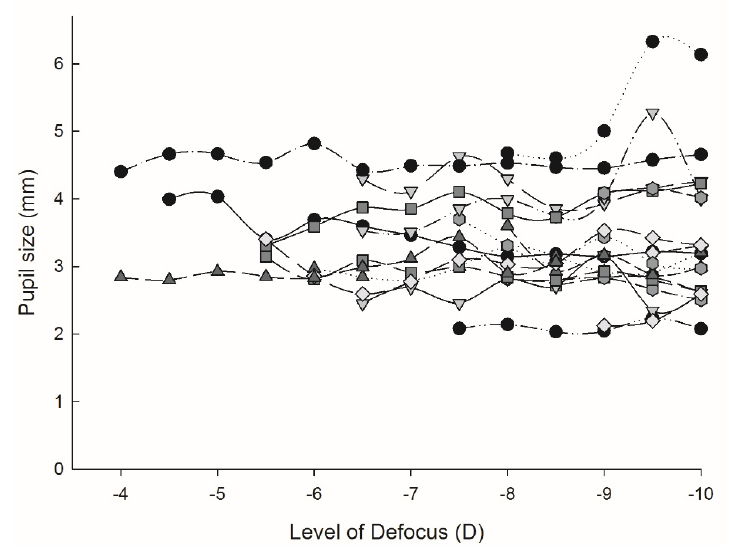
Figure 8. Pupil size, beyond maximum accommodation stimulation. The pupil size at each defocus lens once maximum accommodation had been stimulated n = 19, each symbol represents a participant’s pupil size.